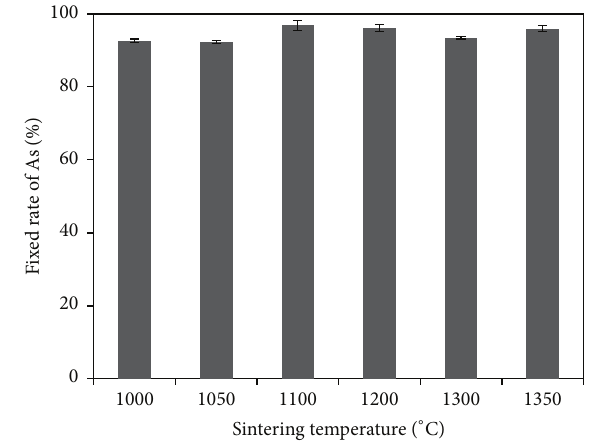
Figure 3: The fixed rates of As in sintered products at different sintering